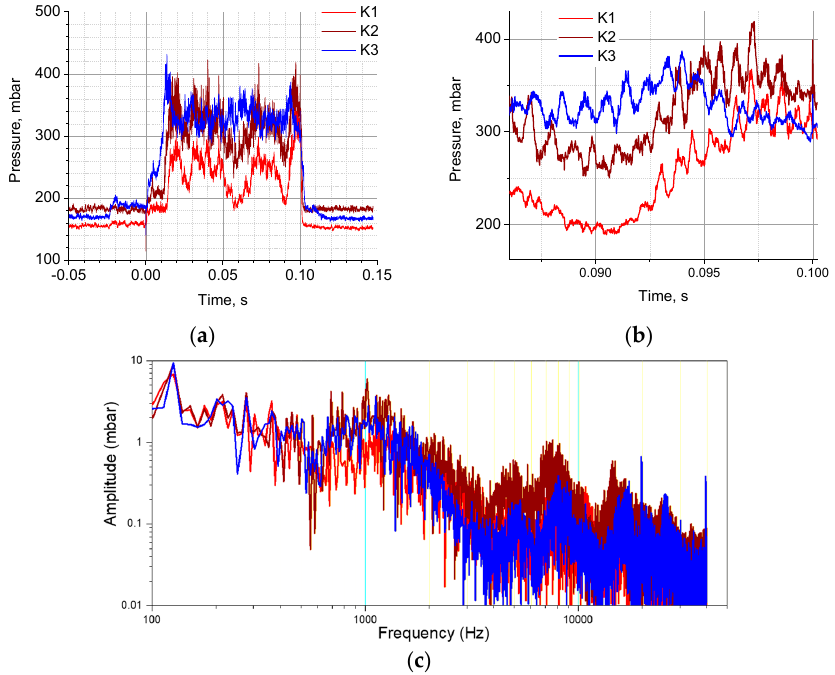
Figure 30. Data on fast pressure measurements (Kulite™ sensors): ( a ) time series; ( b ) time-resolved traces; ( c ) tpectra of pressure oscillations.